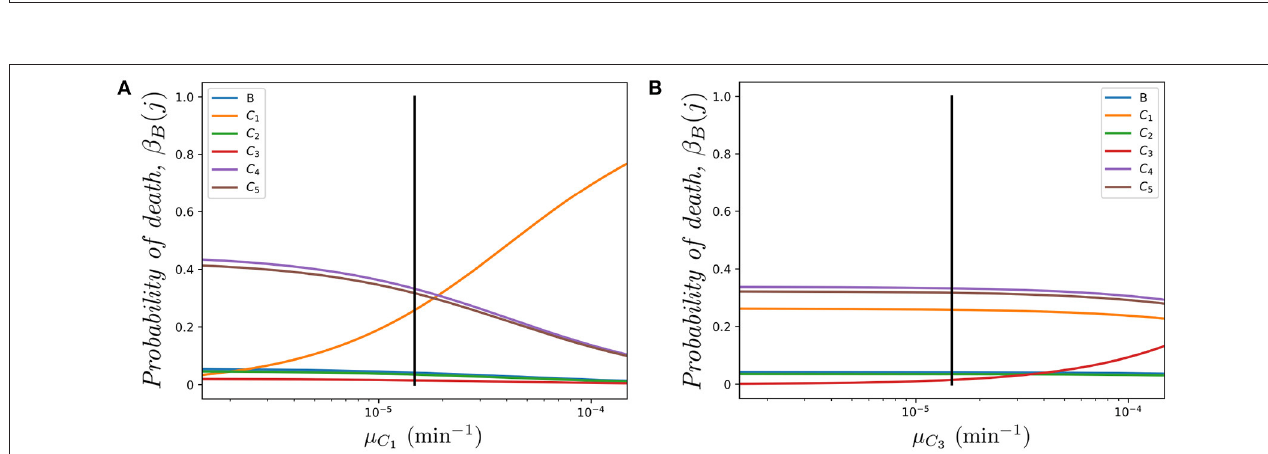
on the probability β B ( j ) of dying in different compartments j ∈ { B , C 1 , ... , C 5 } , for a cell starting at blood. (A) Varying µ C i